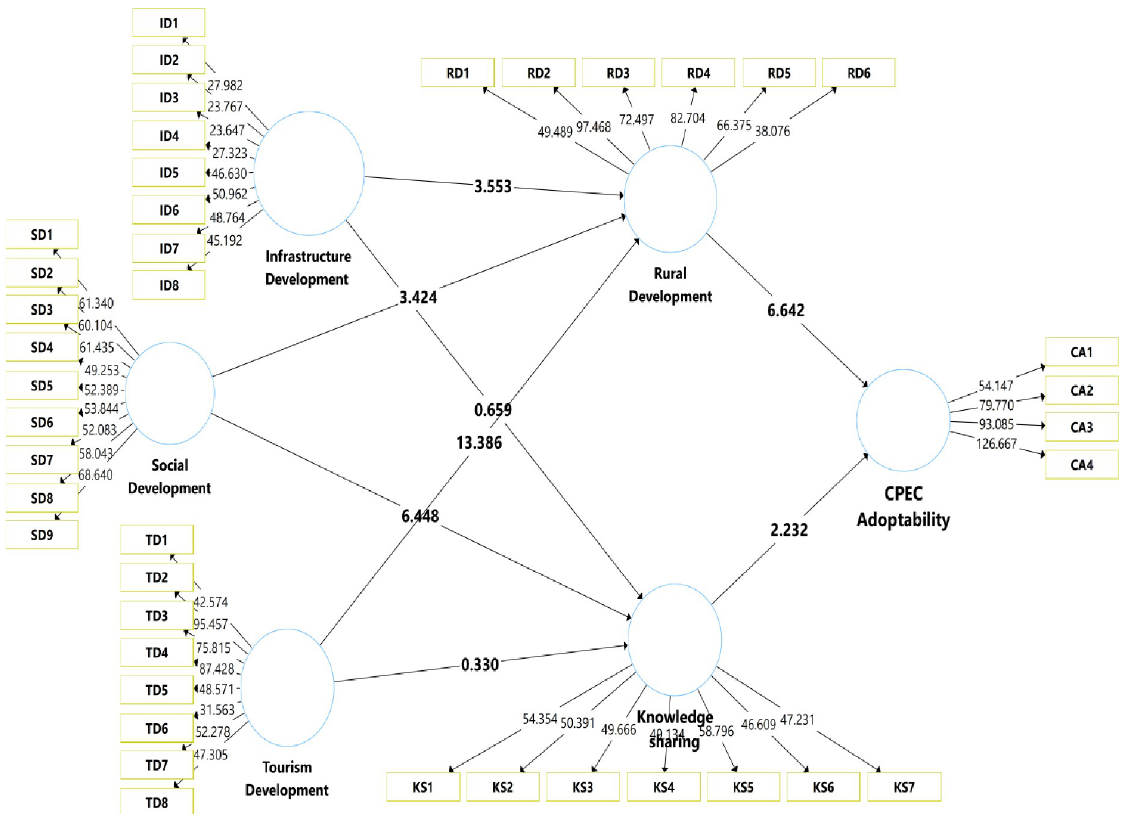
Fig 4. The SEM results with t